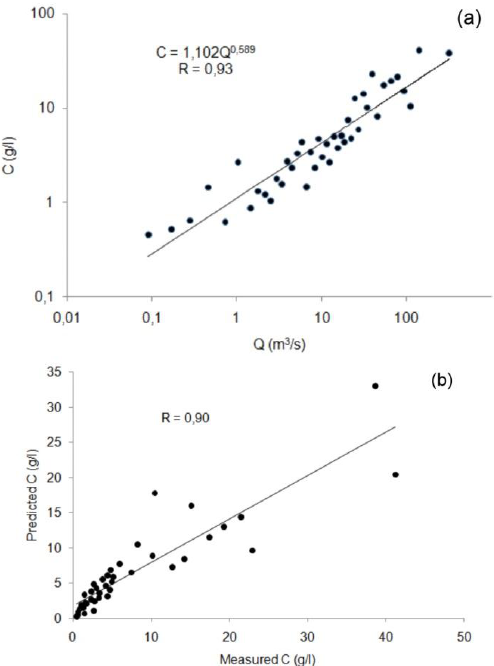
Figure 3: Scatter plot of : (a) relationship between water discharge and sediment concentration, (b) observed and estimated sediment concentration.